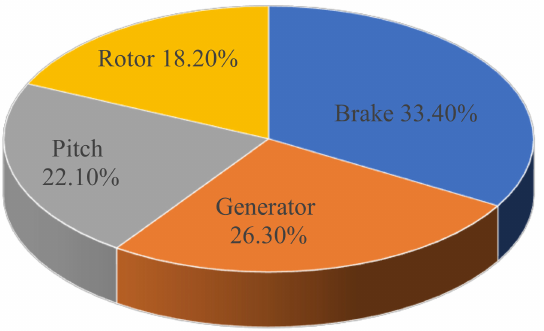
Figure 12. The maintenance cost savings percentage of 5 OWTs main equipments.